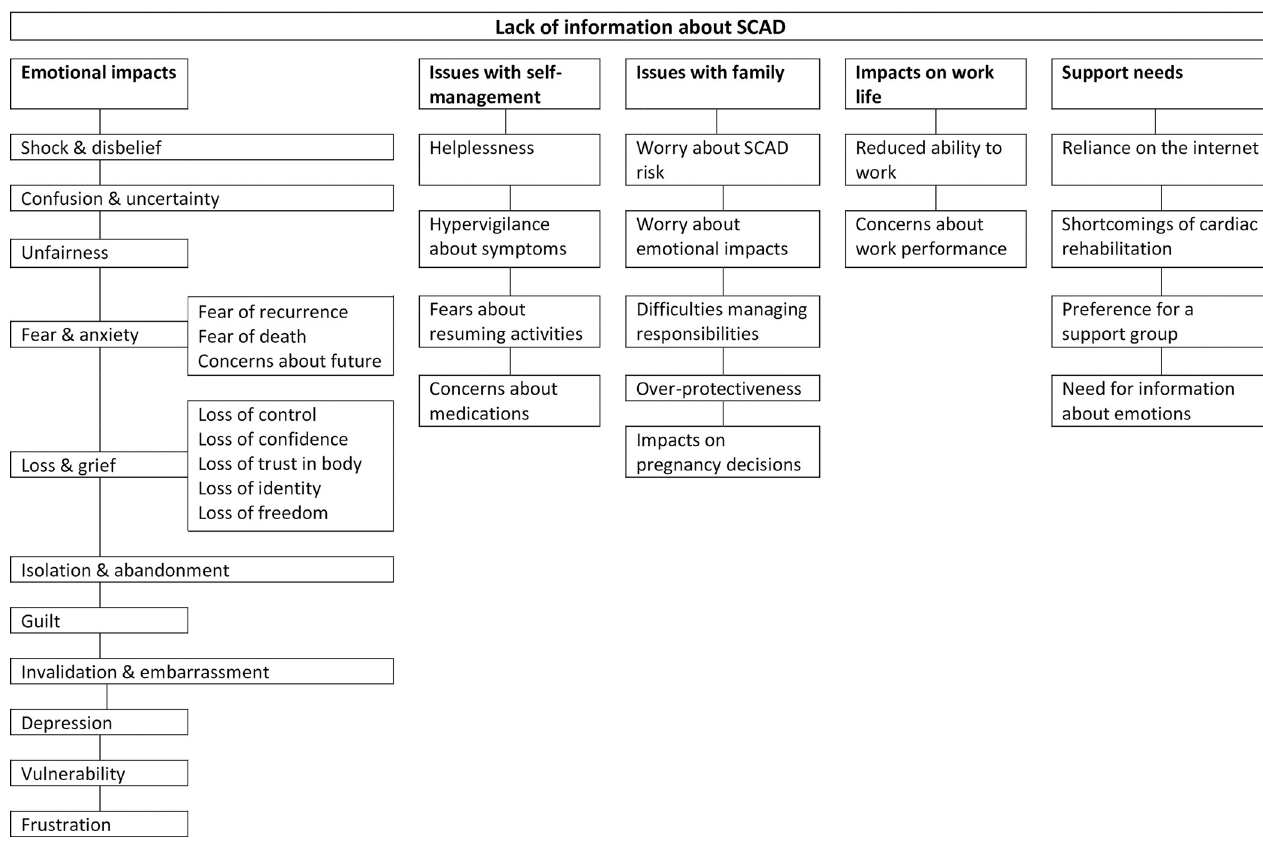
Fig 1. Themes and